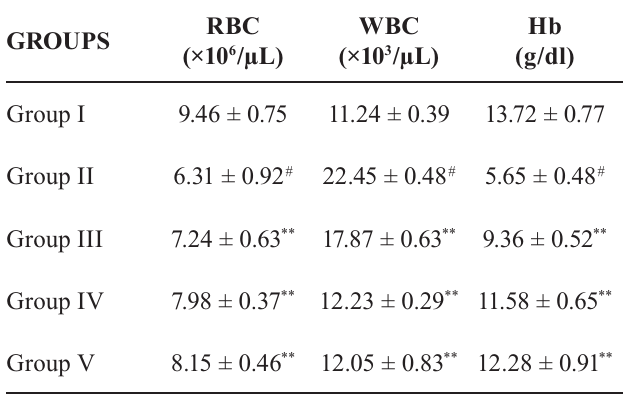
TABLE I - Effect of ginkgolic acid on RBCs, WBCs and Hb in CFA-induced arthritis in